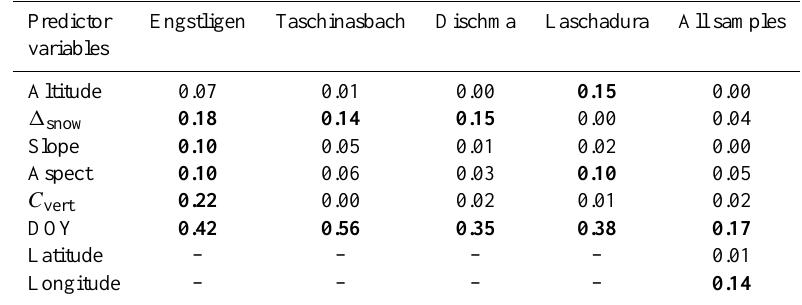
Table 1. Correlation coefficients ( R 2 ) for different predictor variables and the response variable δ 2 H. Predictor Engstligen